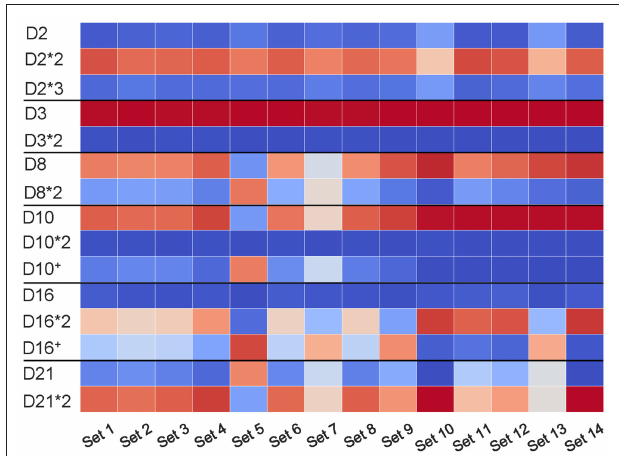
FIGURE 6 | Usage of D genes with known and novel allelic variants across all HEALTHY datasets. Horizontal black lines sub-partition the matrix into six sub-matrices corresponding to allelic variants of D2 (IGHD2-2), D3 (IGHD3-3), D8 (IGHD2-8), D10 (IGHD3-10), D16 (IGHD3-16), and D21 (IGHD2-21). For each D gene and each dataset, we computed the percentage of usage of each variant. Values in cells vary from 0 (blue) to 100 (red). White cells correspond to values ∼ 50% and likely represent cases when a single individual carries different variants of a given D genes on two different